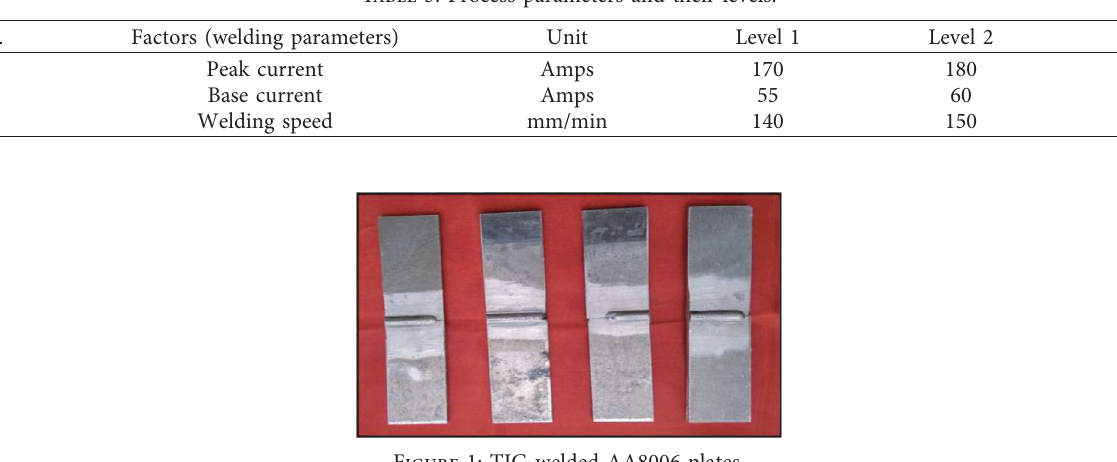
Table 3: Process parameters and their levels.